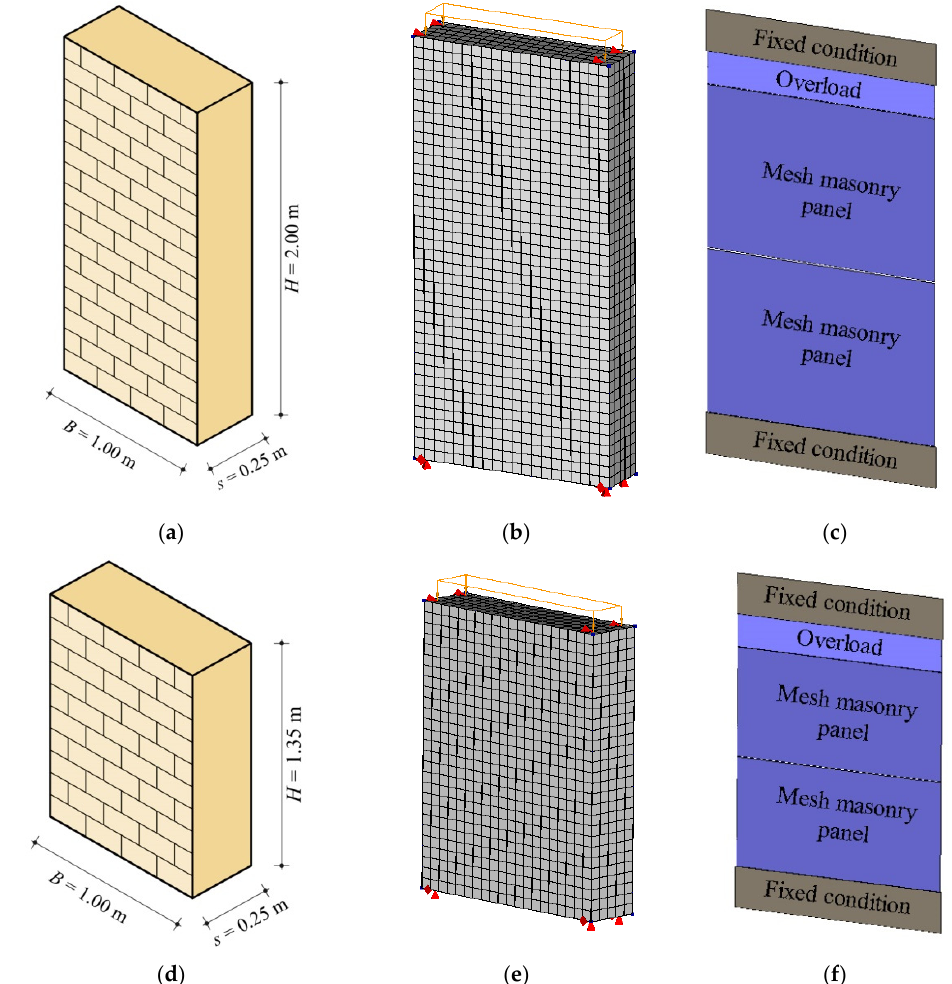
Figure 4. Slender wall [22]: ( a ) geometry; ( b ) FE model; ( c ) DME model. Squat wall [22]: ( d ) geometry; ( e ) FE model; ( f ) DME model.